Question: Give a one-sentence summary of this figure.
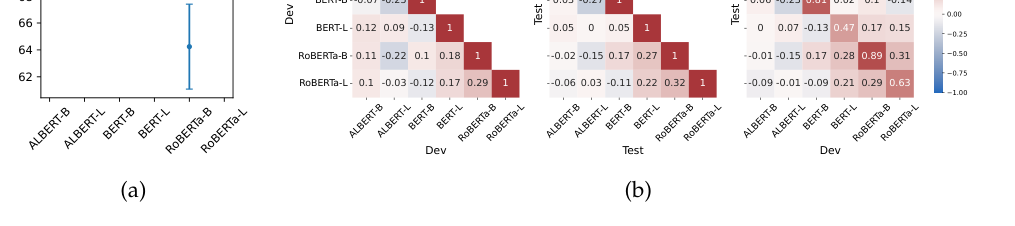
Answer: (a): Mean and standard deviation of M-MEM scores of all prompts across models on the dev set. (b): Correlations (Kendall’s τ) of the M-MEM scores of prompts across models. Left: correlations for the dev set scores. Middle: correlations for the test set scores. Right: correlations between dev and test set scores.